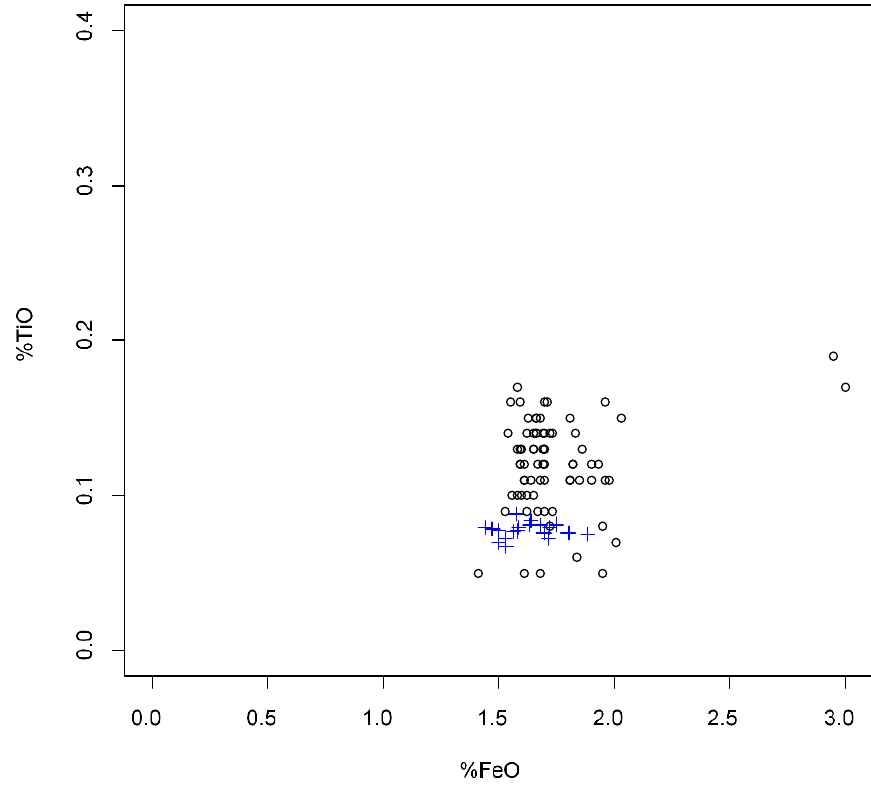
Figure A2. % TiO and FeO of reference Lairg A shards from Tephrabase (Newton et al . 2007), displayed as black circles, compared with shards from BADF